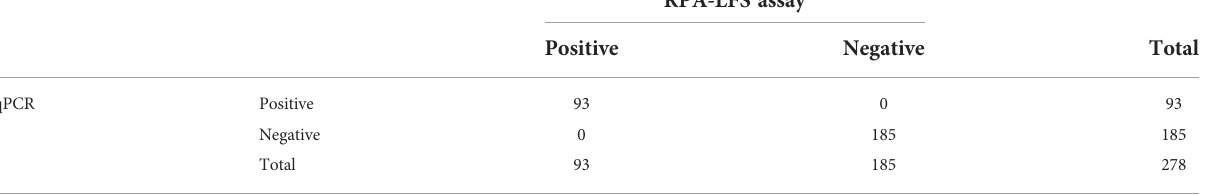
TABLE 3 The prevalence of E. faecalis in 278 clinical isolates with the RPA-LFS and qPCR assays (summarized).